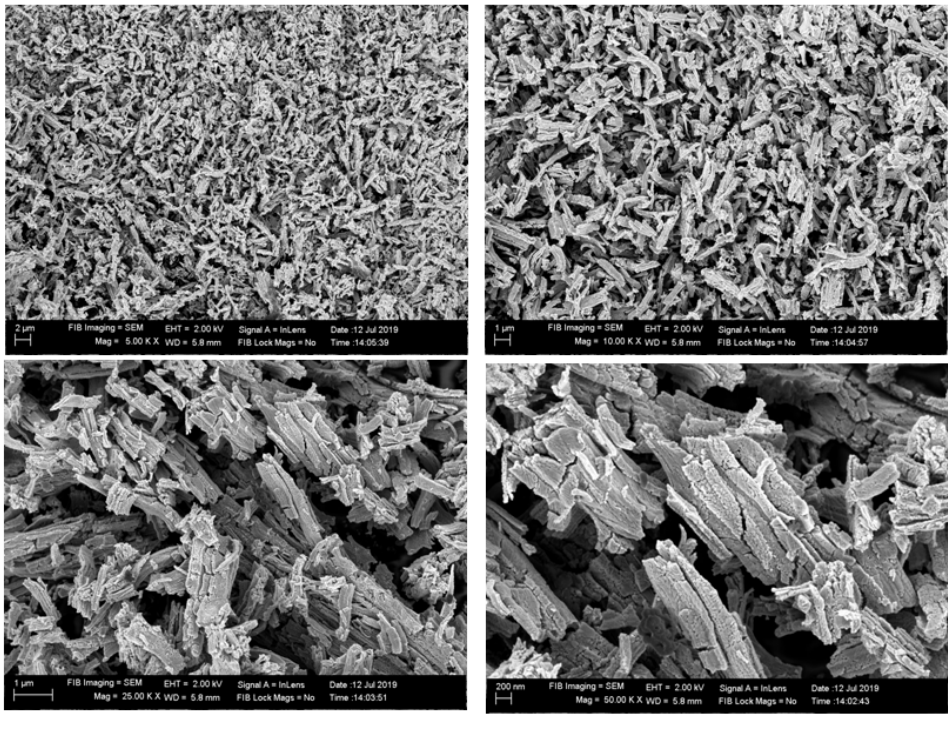
Figure 12: SEM micrographs of ZnO NPs synthesized at pH 10.5.